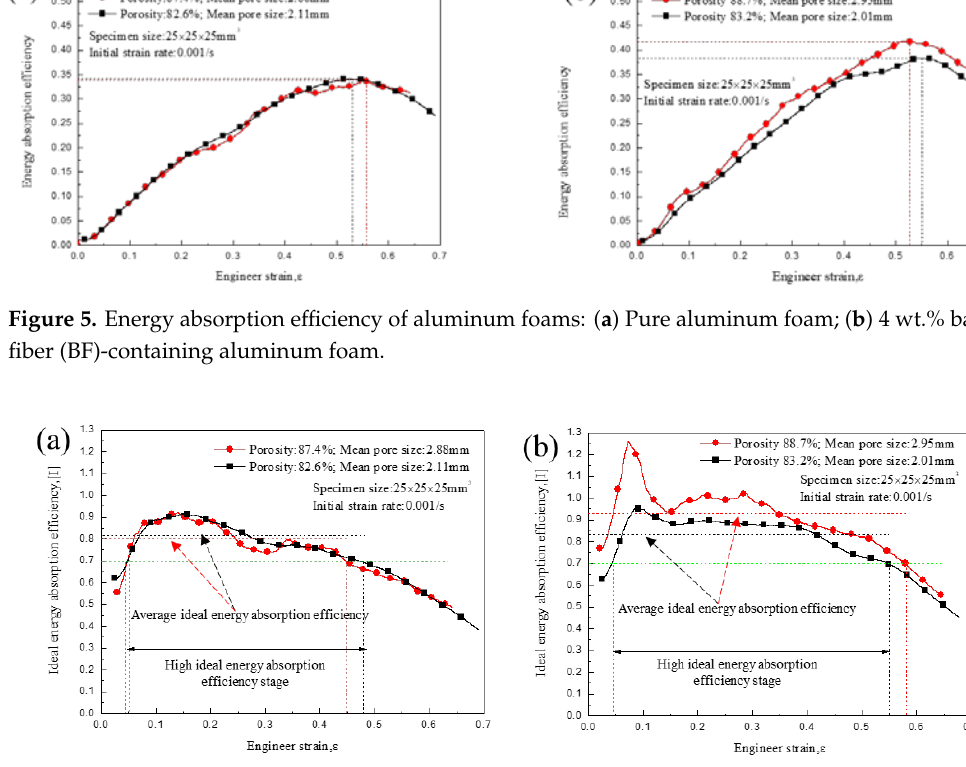
Figure 6. Ideal energy absorption efficiency of aluminum foams: ( a ) Pure aluminum foam; ( b ) 4 wt.% BF-containing aluminum foam.